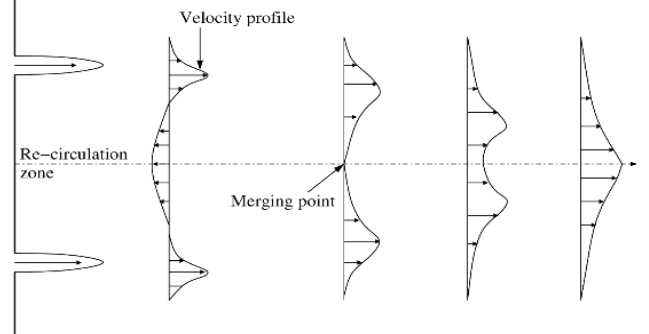
Figure 1. Centerline velocity distribution in multiple jets.